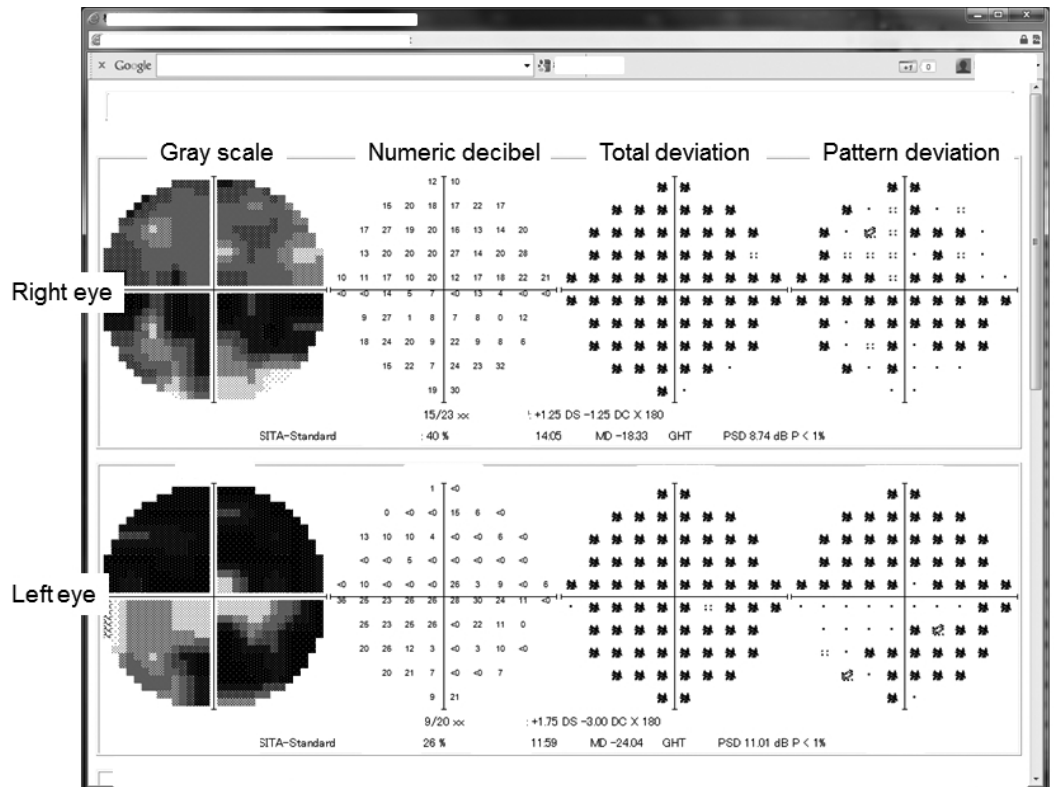
Figure 3. Results of the static visual field test using the Humphrey visual field test, including gray scale maps, numeric decibels, and the total and pattern deviation. MD: mean deviation, PSD: pattern standard